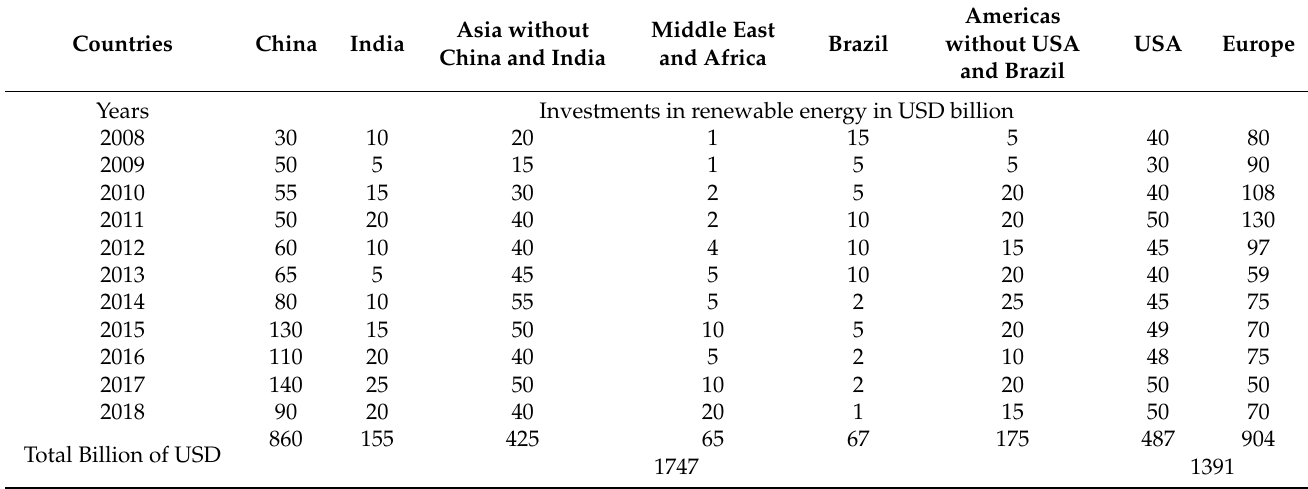
Table 5. Comparison of investments in USD billion in RES in various countries of the world (approximate values) [1,8]. Asia without Countries China Investments in renewable energy in USD